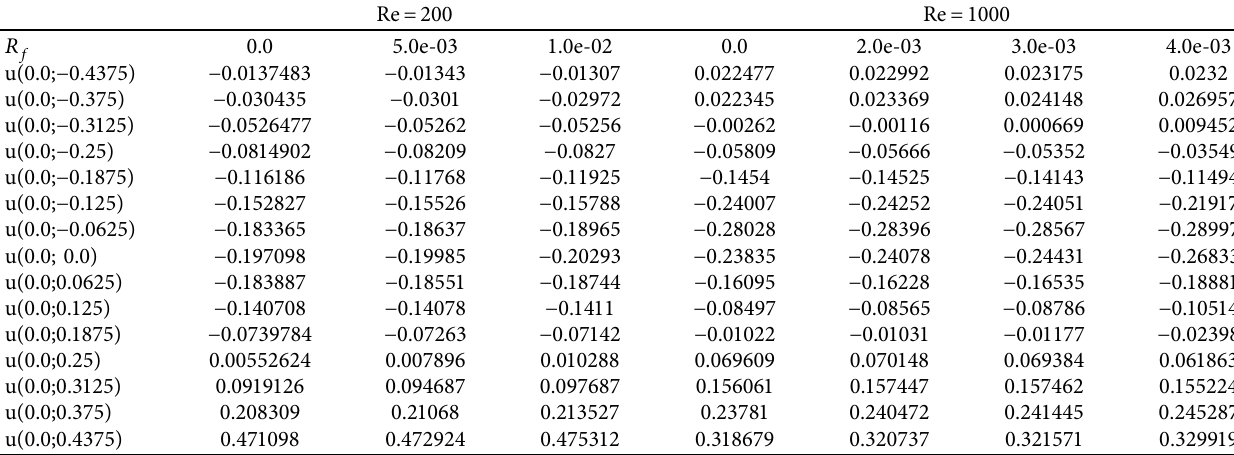
Table 1: Horizontal velocity component “ u ” for Re � 200 and Re � 1000 with varying values of the fluid relaxation parameter.